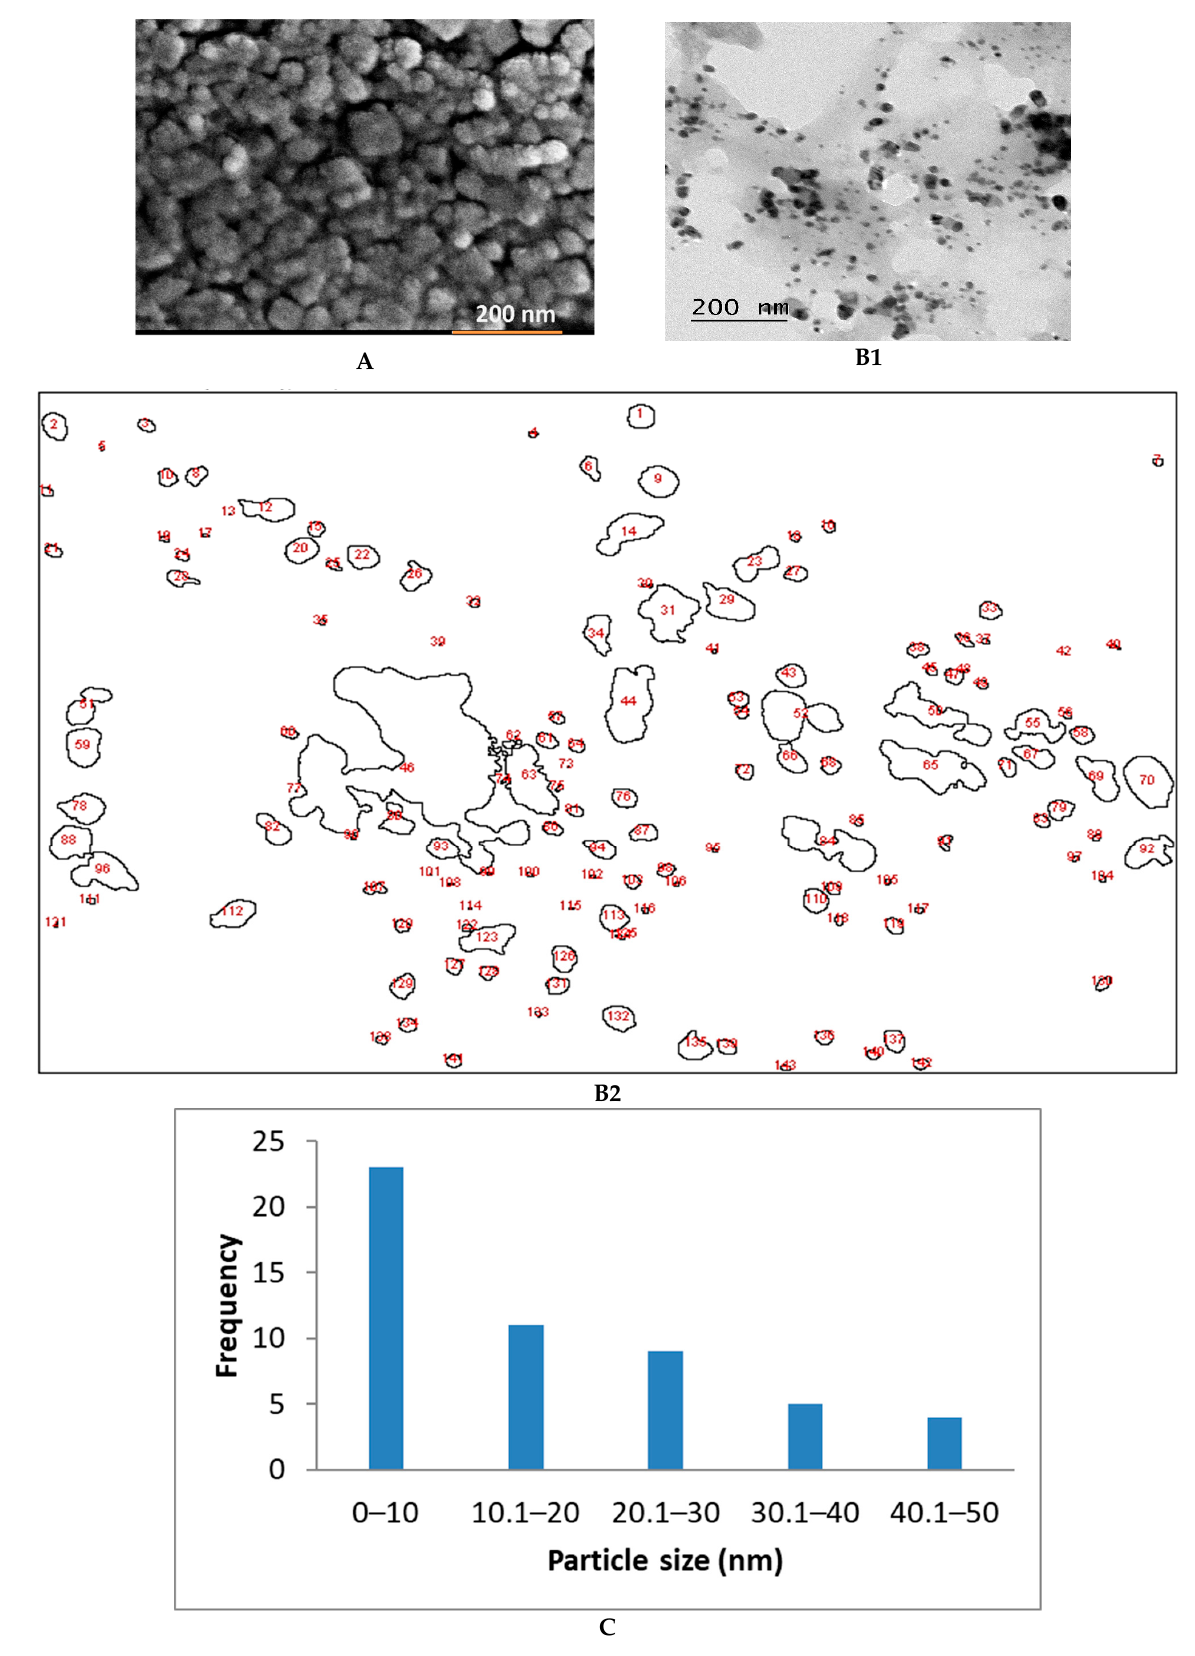
Figure 2. Morphological features of synthesized AgNPs. ( A ) SEM image at the 200 nm scale; ( B1 and B2 ) TEM images; ( C ) average size distribution histogram representing AgNP size range. Table 1. Silver nanoparticle size distribution based on TEM data (Figure B2).